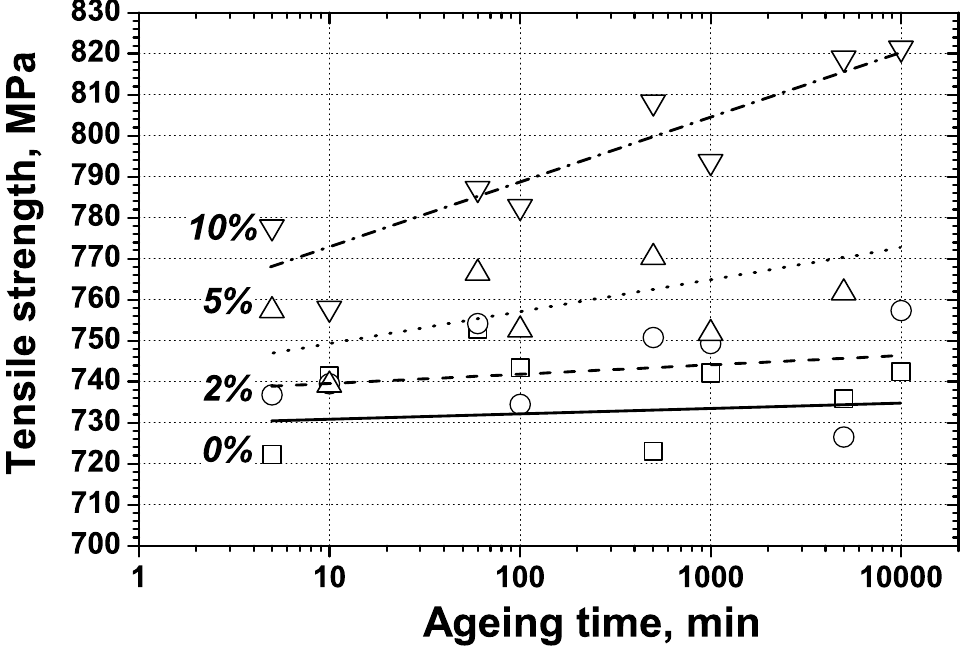
Figure 7. Tensile strength after aging as function of the aging time for aging at 170 ◦ C from 5 to 10,000 min for 0%, 2%, 5%, and 5% prestrain for the temper rolled TRIP5 steel.